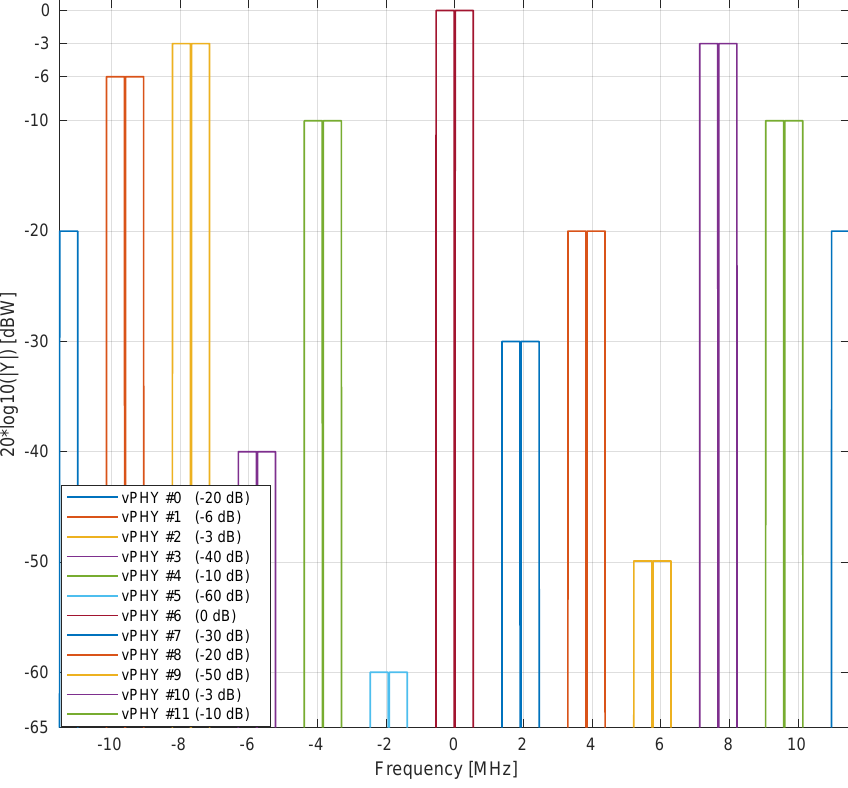
Figure 13. Closer look at the frequency-domain boost